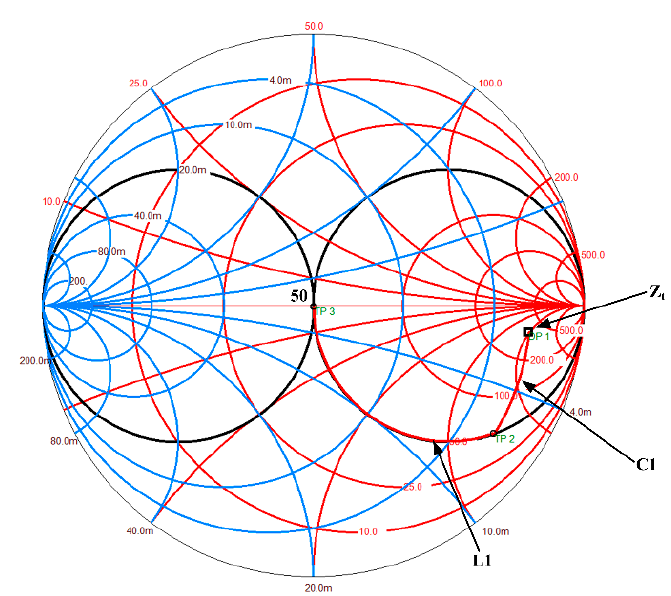
Figure 6. The used EIM networks.